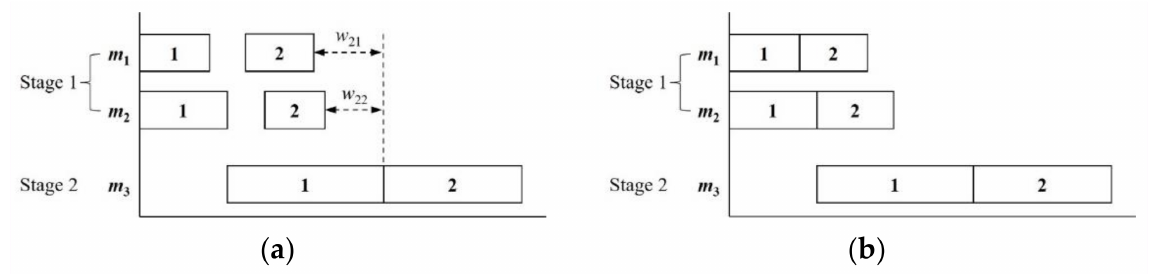
Figure 1. Example schedules with two jobs: ( a ) with waiting time constraints; ( b ) without waiting time